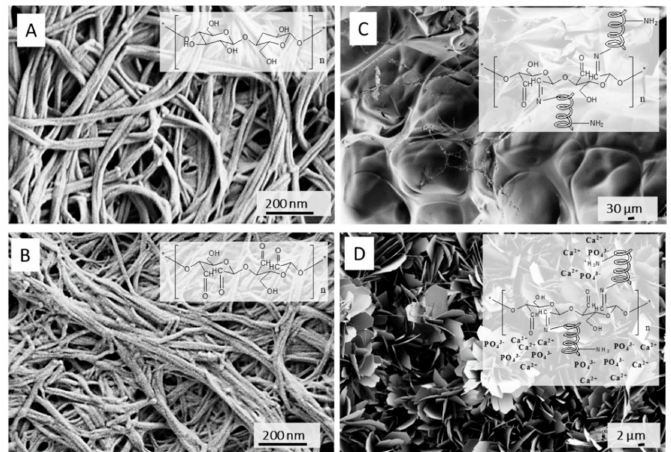
Figure 7. Scanning electron microscopy images of ( A ) native and post-synthetically modified BC; ( B ) oxidation with NaIO 4 ; ( C ) further coupling with gelatin (GEL), carbodiimide crosslinking and freeze-thawing; ( D ) in situ mineralization by incubation in (10 × concentrated) simulated body fluid medium. Adapted from [92], with permission from Nanomaterials,